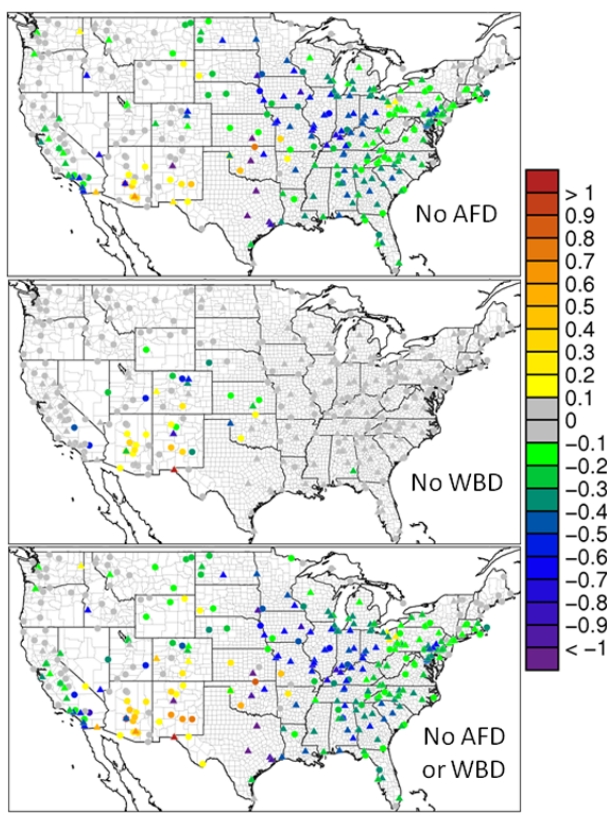
Fig. 10. Difference in average soil concentration bias (µgm − 3 ) for spring (2006) between the CMAQ simulation with no AFD emis- sions and the base CMAQ simulation (No AFD – Base; top), the CMAQ simulation with no WBD and the base CMAQ simulation (No WBD – Base; middle), and the CMAQ simulation with no WBD or AFD emissions and the base CMAQ simulation (No AFD or WBD – Base; bottom). Circles indicate IMPROVE network sites and triangles indicate CSN